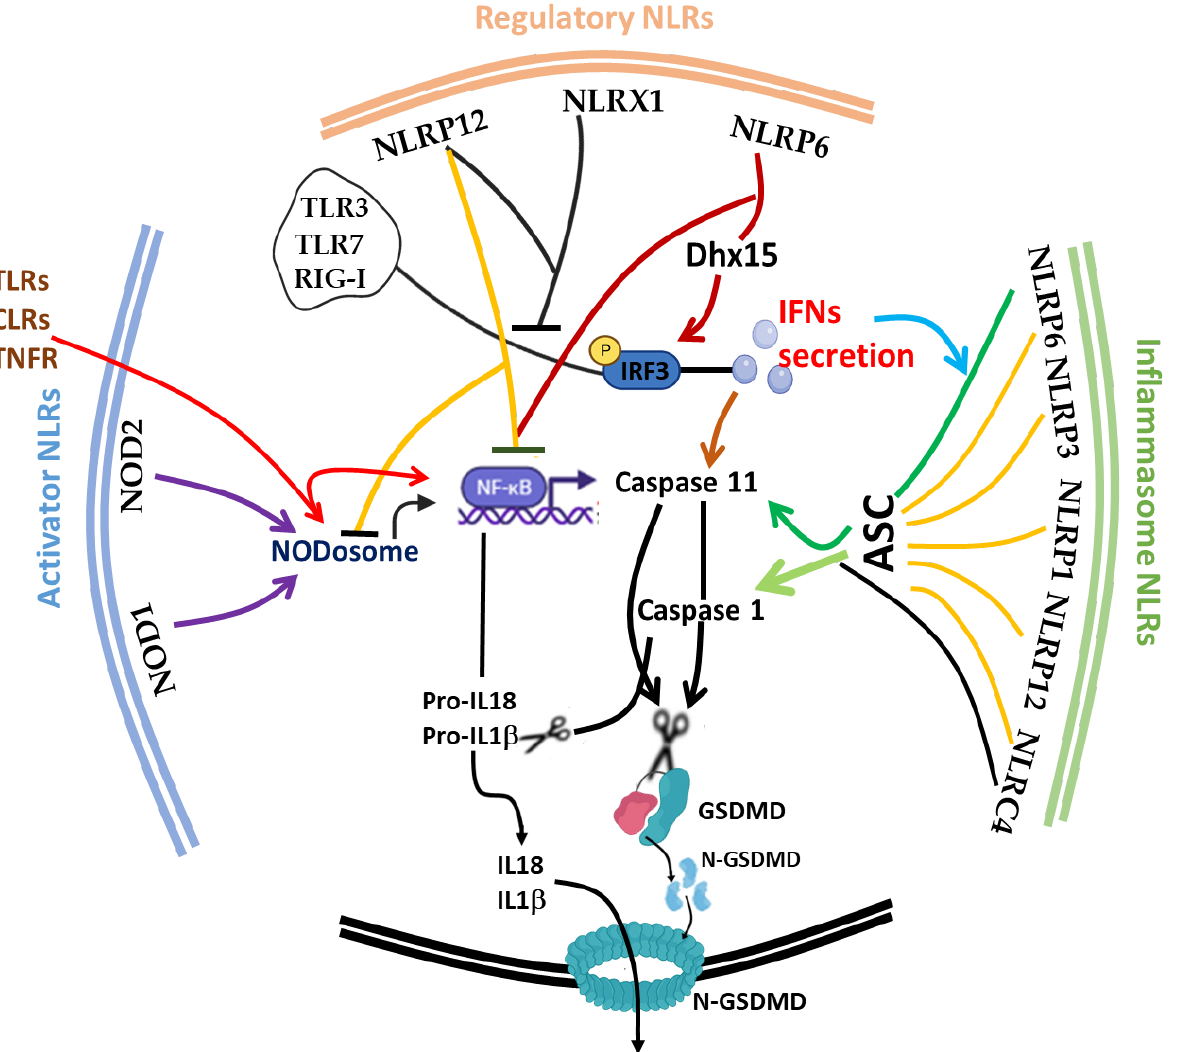
Figure 3. The interplay between the principal molecules of pyroptosis and NOD-like receptors: Caspase 1, GSDMD, IL-1 β , IL-18, caspase 11 and IFN-I are principal mediators of pyroptosis. Caspase 1 and 11 cleave GSDMD and the N-terminal GSDMD loads onto the plasma membrane to form a pore and promotes the release of IL-1 β and IL-18. The inflammasome NLRs are the upstream sensors for caspase 1 activation via their complex formation with ASC and transcriptional basal level of ASC, inflammasomes, such as NLRP3, caspase 11 and immature cytokines (pro-IL1 β and pro-IL18), are upregulated along with NF- κ B induced downstream of TLRs, CLRs, TNFR and NODosome signaling pathways. Cytosolic recognition of pathogens by interferon-related receptors, such as TLR3, TLR7 and RIG-I, also induce IFN-I production, which can prime NLRP6 for caspase 11 activation, and then caspase 11 further enhances the caspase 1-mediated pyroptosis. Members of regulatory NLRs act to suppress the pathway of each critical molecule; for instance, NLRP12 and NLRX1 interfere with RIG-I signaling cascade, canonical and noncanonical NF- κ B pathways. TLRs, Toll-like receptors; CLRs, C-type lectin receptors; TNFR, Tumor necrosis factor receptor 1; RIG-I, Retinoic acid-inducible gene I; TLR3/7, Toll-like receptor 3/7; IFNs, Type 1 interferon; NOD1/2, Nucleotide-binding oligomerization domain-containing protein 1/2; NLRP1/3/6/12, NOD-like receptor family pyrin domain-containing 1/3/6/12; NLRX1, Nucleotide-binding oligomerization domain, leucine-rich repeat containing X1; IRF3, Interferon regulatory factor 3; ASC, Adapter apoptosis-associated speck-like; GSDMD, Uncleaved Gasdermin-D; N-GSDMD, Cleaved N-terminal Gasdermin-D.